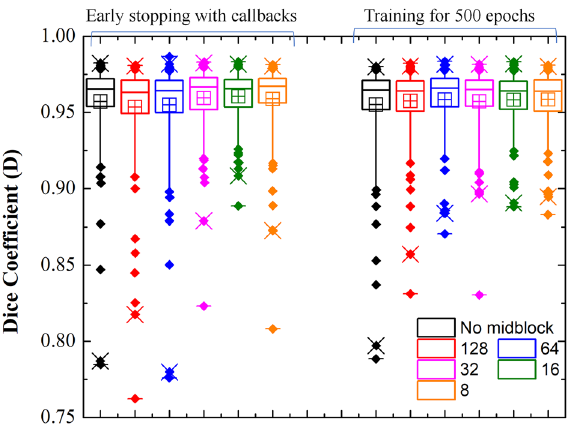
Figure 9. Boxplot showing the effect of bottleneck narrowing with attention on the segmentation of FAZ area. Narrowing of channel with attention at the bottleneck of LWBNA_Unet is significantly effective for precise segmentation of FAZ, irrespective different model training